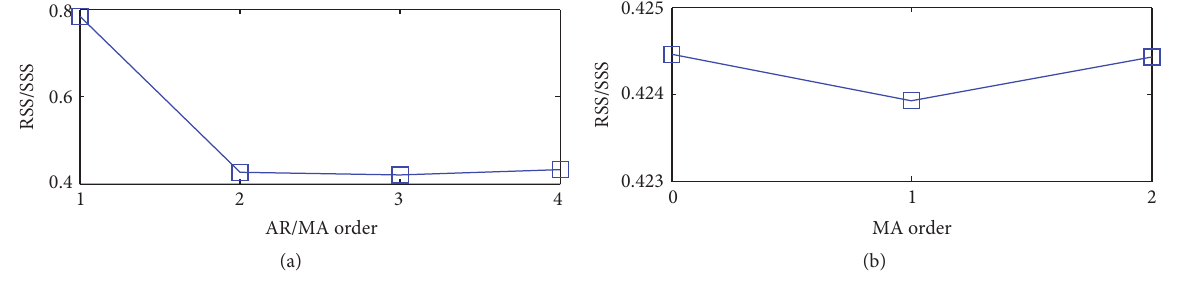
Figure 11: RPLR-FS-TARMA model order selection: (a) AR order and (b) MA